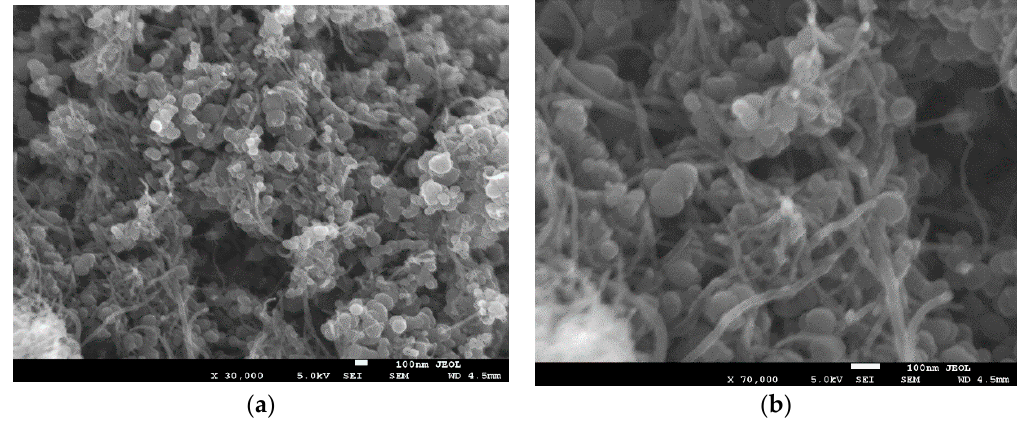
Figure 1. The characterization of the CNTs ‐ Boron processed sample before sintering. ( a ) Low magnification (30,000×); ( b ) High magnification (70,000×).